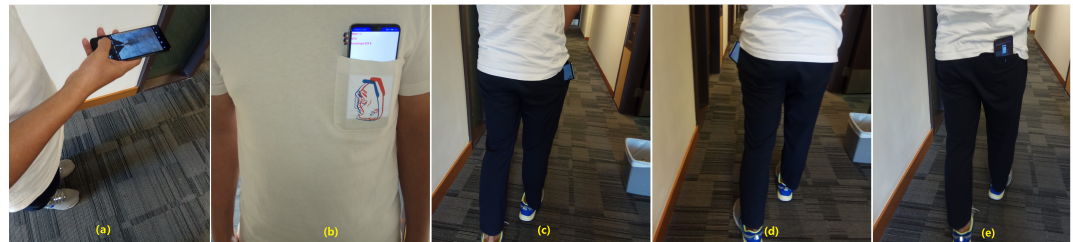
Figure 11. Smartphone posture recognition experiment. ( a ) is holding smartphone; ( b ) is in the chest pocket; ( c ) is in the right trouser pocket; ( d ) is in the left trouser pocket; ( e ) is in the buttock